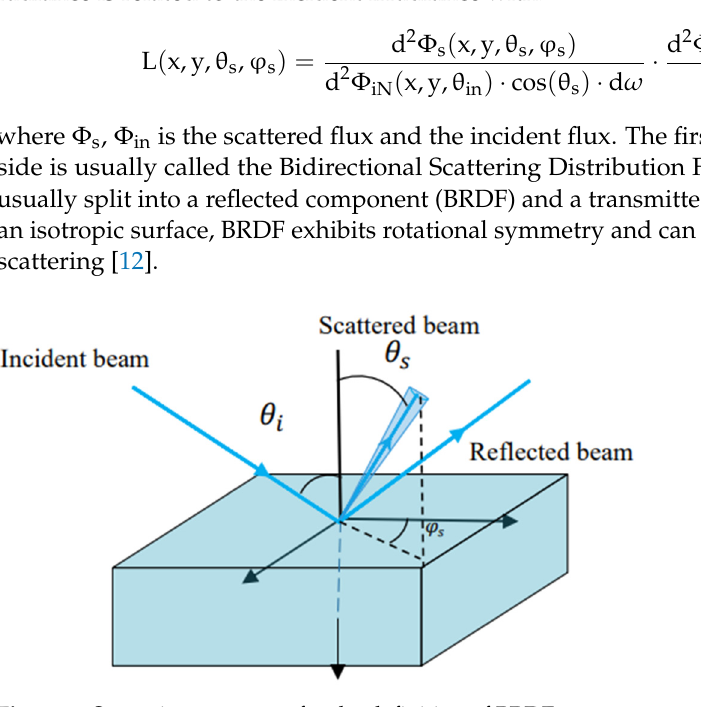
Figure 1. Scattering geometry for the definition of BRDF.